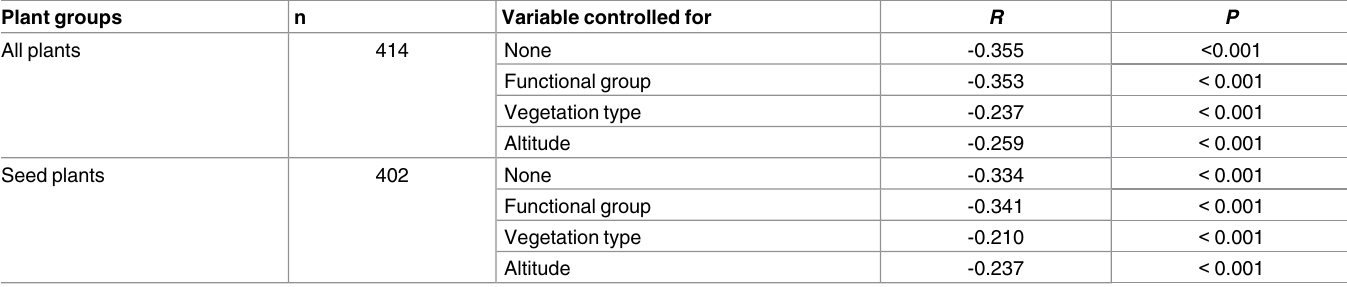
Table 3. Comparison of the results of bivariatecorrelation analysisand partial correlation analysesof N mass vs. δ 13 C after controlling for functional group, vegetation type, and altitude. Plant